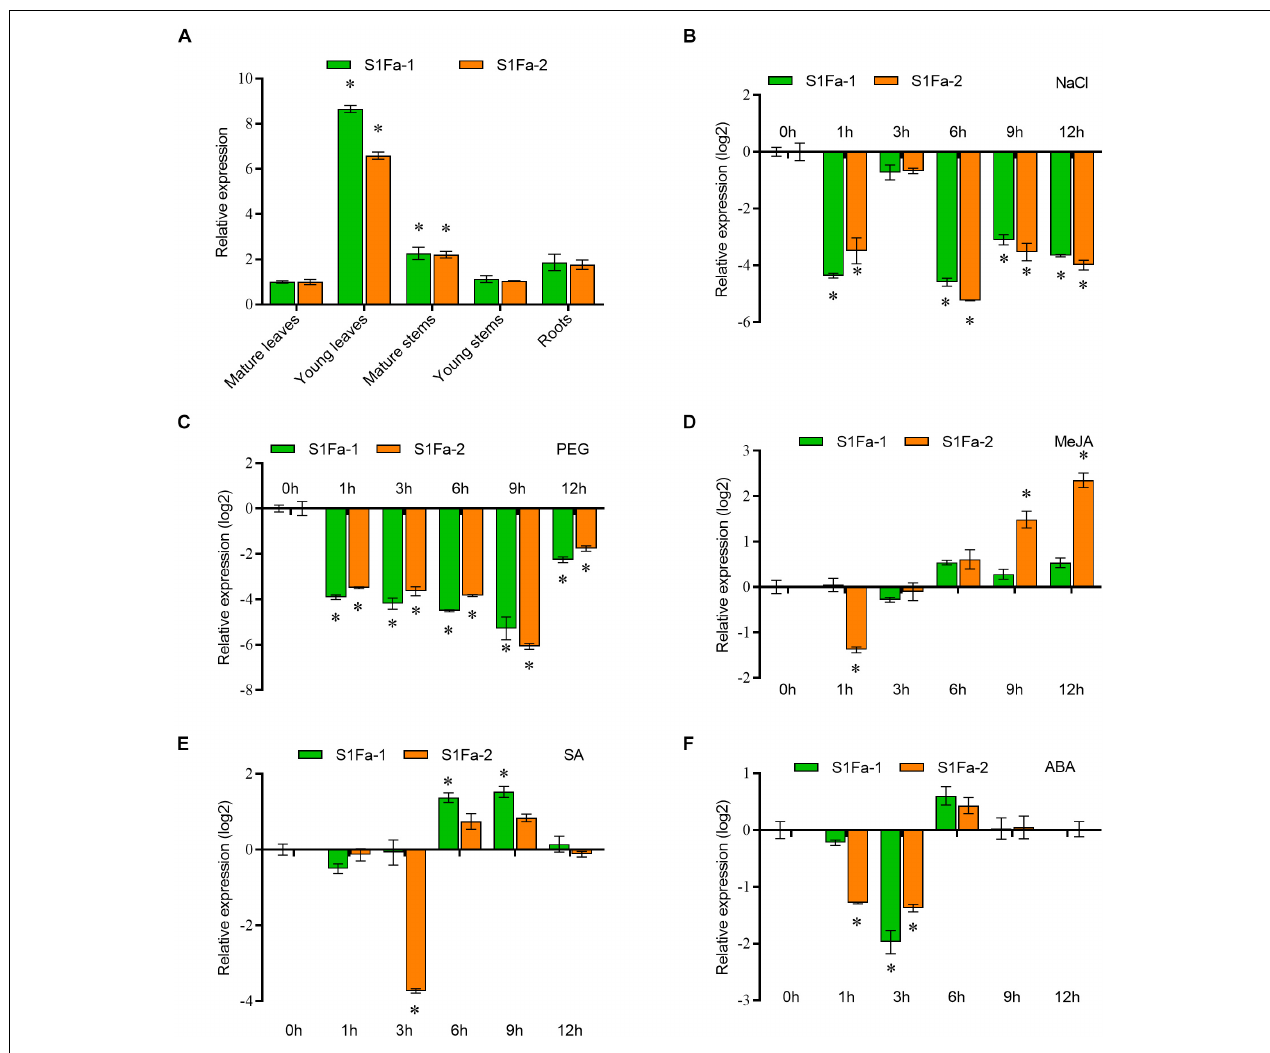
FIGURE 4 | The expression patterns of S1Fa-like genes. (A) Expression of PtS1Fa1 and PtS1Fa2 in different tissues of Populus trichocarpa . Tissues from 5-week-old plants were used for the analysis. The relative expression of PtS1Fa1 and PtS1Fa2 in the mature leaves was set as 1 to normalize its expression in other tissues. (B) Expression profiles of PtS1Fa1 and PtS1Fa2 in young leaves of P. trichocarpa responding to 150 mM NaCl. (C–F) Young leaves were used for analysis under the conditions of 20% PEG6000 treatment (C) , 100 µ M Me-JA treatment (D) , 100 µ M SA treatment (E) , and 200 µ M ABA treatment (F) . All the solutions were watered on roots of P. trichocarpa and P. trichocarpa plants growing under normal conditions were served as the mock controls. The expression values were converted by log2. Error bar indicates the standard deviation (STD) of the three biological replicates. Asterisk ( ∗ ) represents significant difference compared with WT ( P <